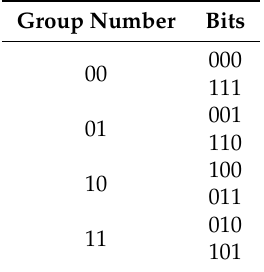
Table 1. Grouping